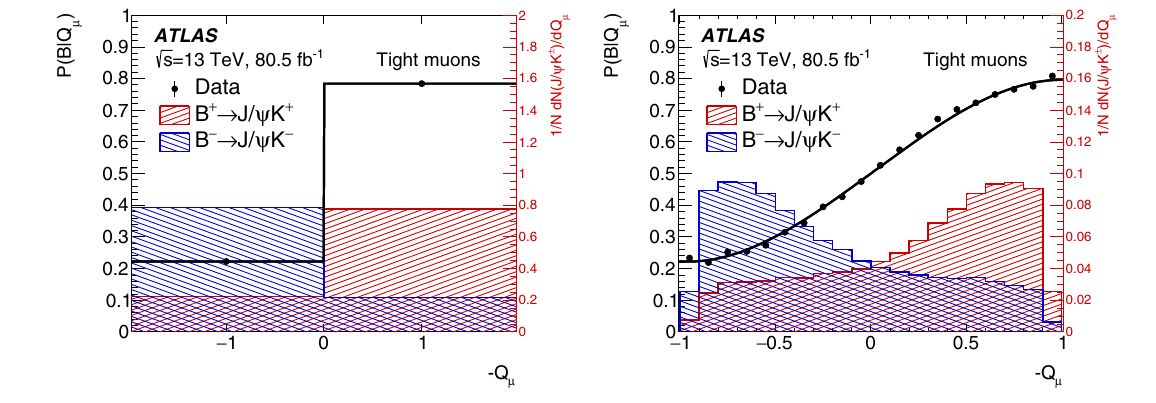
Fig. 2 Cone charge distributions, − Q μ , for Tight muons, shown for casesofdiscretecharge(left),andforthecontinuousdistribution(right). For each plot, in red (blue), the normalised B + ( B − ) cone charge distribution is shown (corresponding to the right axis scale). A B + ( B − ) candidate is more likely to have a large negative (positive) value of Q μ . Superimposed is the distribution of the tagging probability,